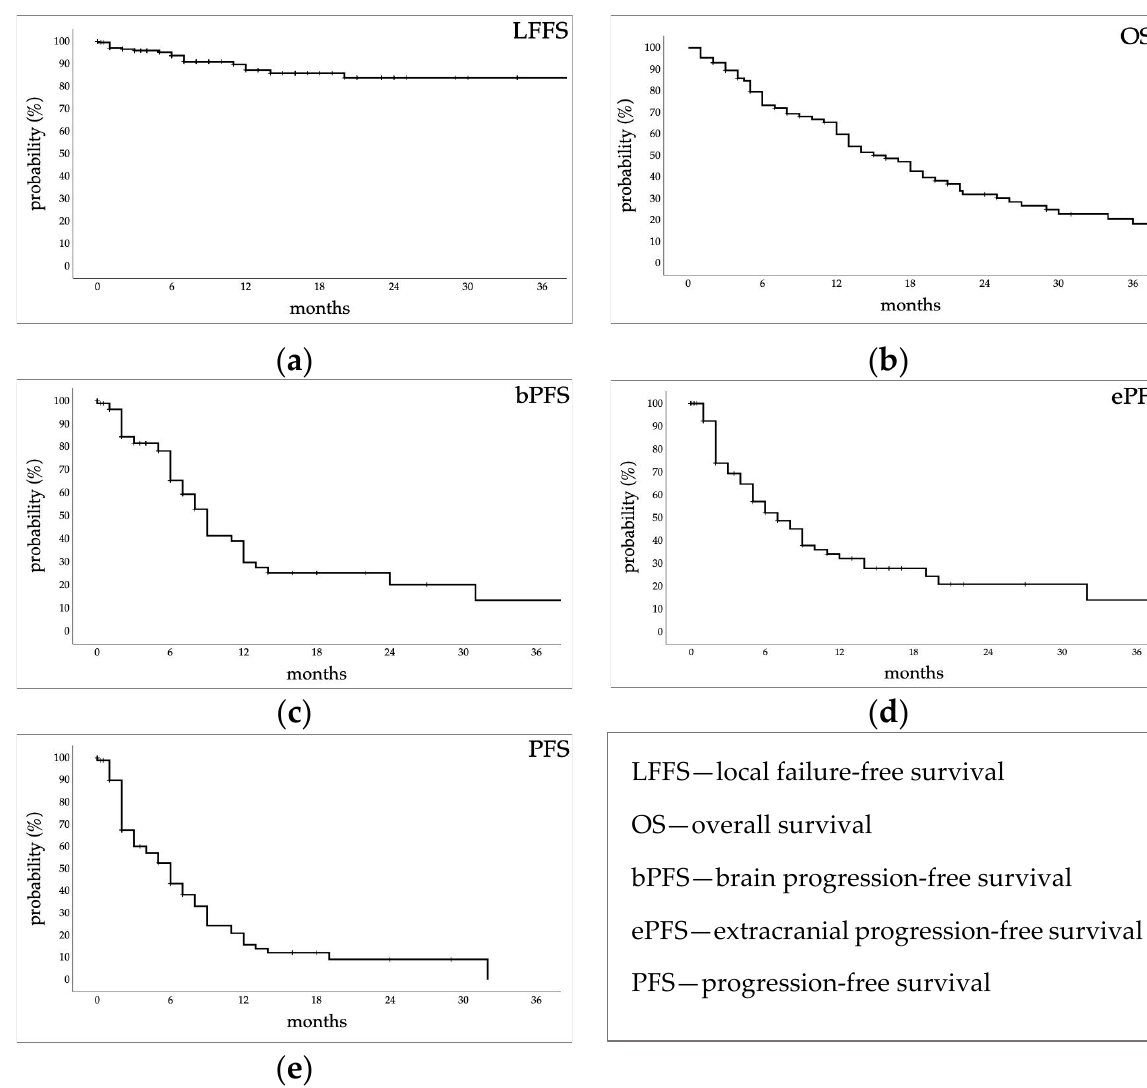
Figure 1. Kaplan–Meier estimated time-to-event curves of ( a ) local failure-free survival, ( b ) overall survival, ( c ) brain progression-free survival, ( d ) extracranial progression-free survival, and ( e ) progression-free survival.